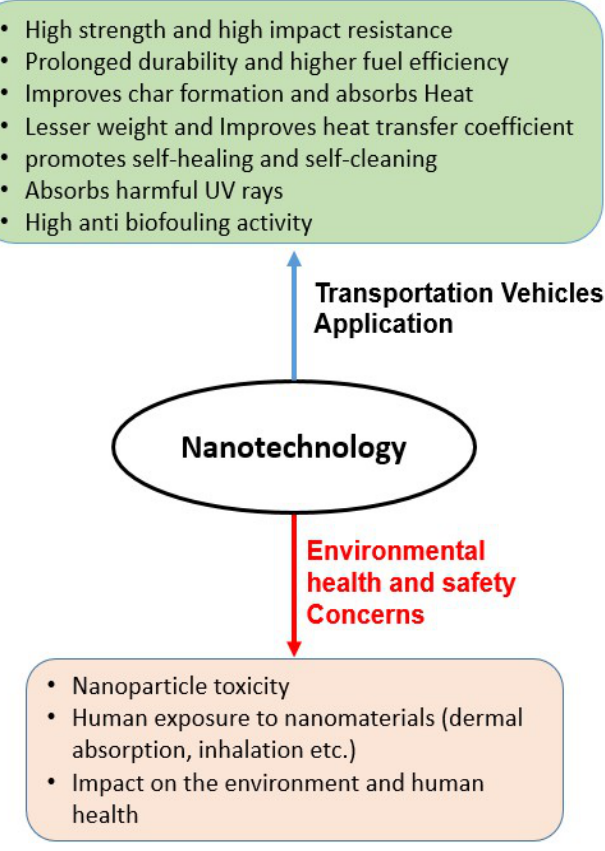
Figure 2. Potential applications of nanotechnology in transportation and the associated environmental health and safety concerns.